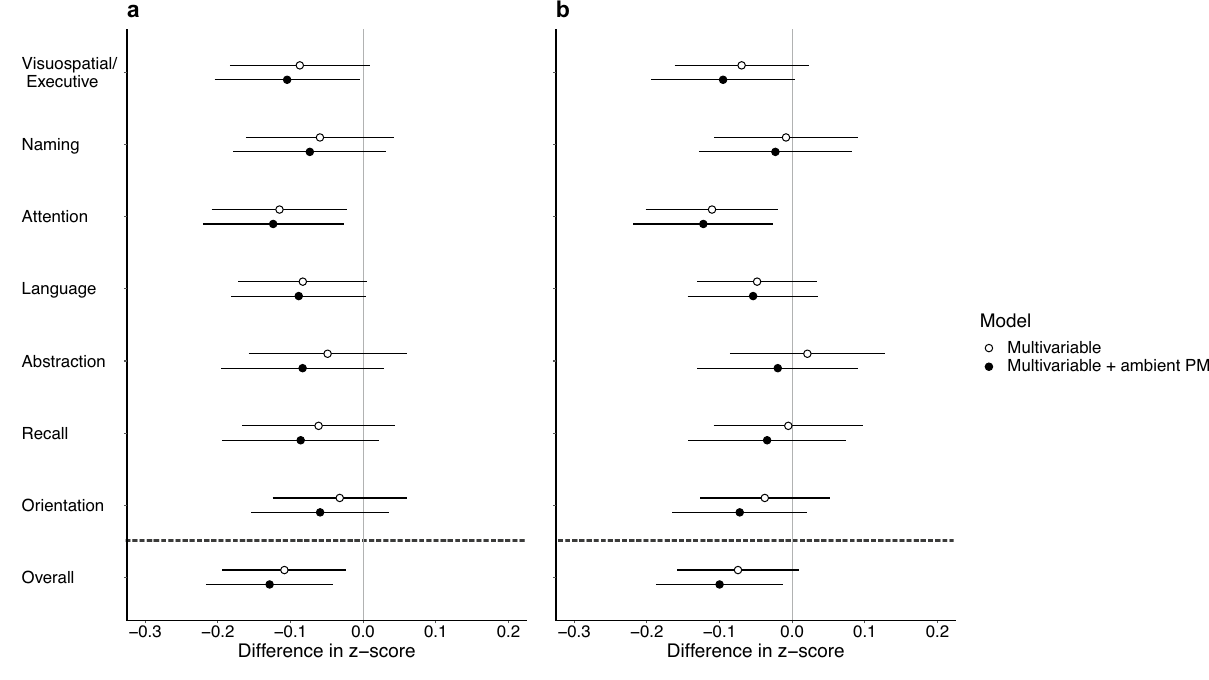
Figure 1. Associations between measures of cognitive function and personal exposures to air pollution in peri- urban northern Chinese adults. ( a,b ) Analyses were performed based on the data of 355 participants. Results from multivariable regression models, with final models (black circles) additionally adjusted for ambient PM 2.5 . Difference in z-score represents the difference in cognitive score associated with an IQR increase in exposure. Data are presented as point estimates of effects (central dots of the error bar) with 95% CIs (corresponding solid lines). The vertical solid line is the reference line. The horizontal dashed line separates estimate for overall cognition from estimates for cognitive domains. ( a ) Personal exposure to PM 2.5 (IQR: 53.2 μg/m 3 ) and MoCA scores. ( b ) Personal exposure to black carbon (IQR: 0.9 μg/m 3 ) and MoCA scores. For detailed estimates of univariable and multivariable regression models, please see Supplementary Table